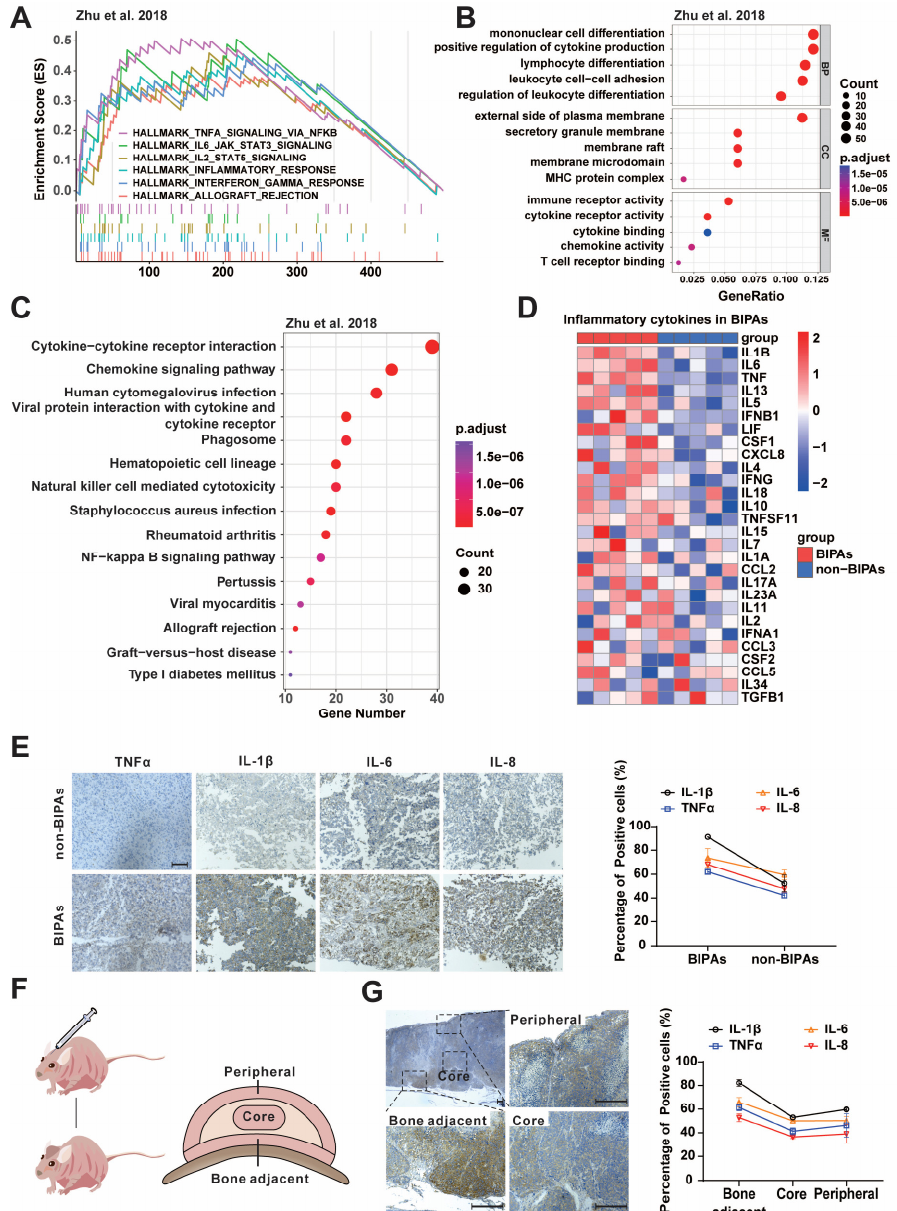
Figure 1. Inflammatory factors in BIPAs. ( A – C ) Multi-GSEA analysis ( A ), GO analysis ( B ), and KEGG ( C ) analysis of PA transcriptomic data in the BIPAs versus the non-BIPAs (RNAseq data from the article Zhu et al., 2018 [5]). ( D ) qPCR of major inflammatory cytokines between BIPAs and non-BIPAs. ( E ) Immunohistochemistry for TNF α , IL-1 β , IL-6, and IL-8 in clinical specimens of GH-PAs between BIPAs and non-BIPAs ( × 200; scale bar, 100 µ m). Quantification, right. ( F ) Schematic diagram of calvaria xenograft PAs in nude mice. The tumors were specimenized with the skull on the coronal plane; the tumor regions were divided into 3 areas as the peripheral area, core area, and bone-adjacent area. ( G ) The distribution of IL-1 β in the xenograft tumor by immunohistochemistry (top left, × 40; scale bar, 200 µ m). The localized images of different areas are magnified separately for the peripheral area (top right, × 200; scale bar, 200 µ m), core area (bottom right, × 200; scale bar, 200 µ m), and bone-adjacent area (bottom left, × 200; scale bar, 200 µ m). Quantification of TNF α , IL-1 β , IL-6, and IL-8,